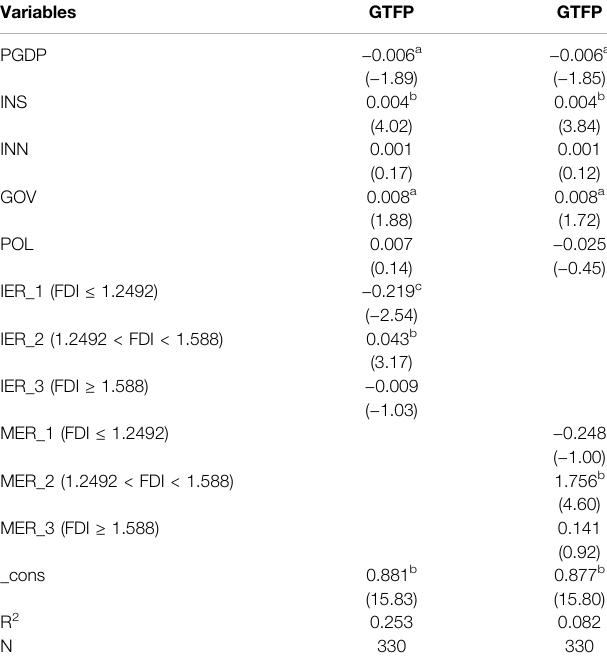
TABLE 7 | Threshold estimation results of environmental regulations on GTFP. Variables